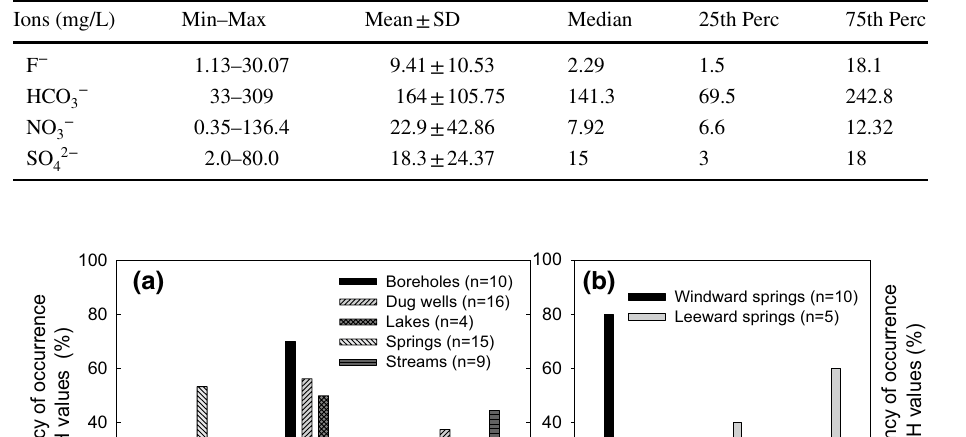
Fig. 6 Physicochemical param- eter distribution in water types a dissolved oxygen (DO), b total dissolved solids